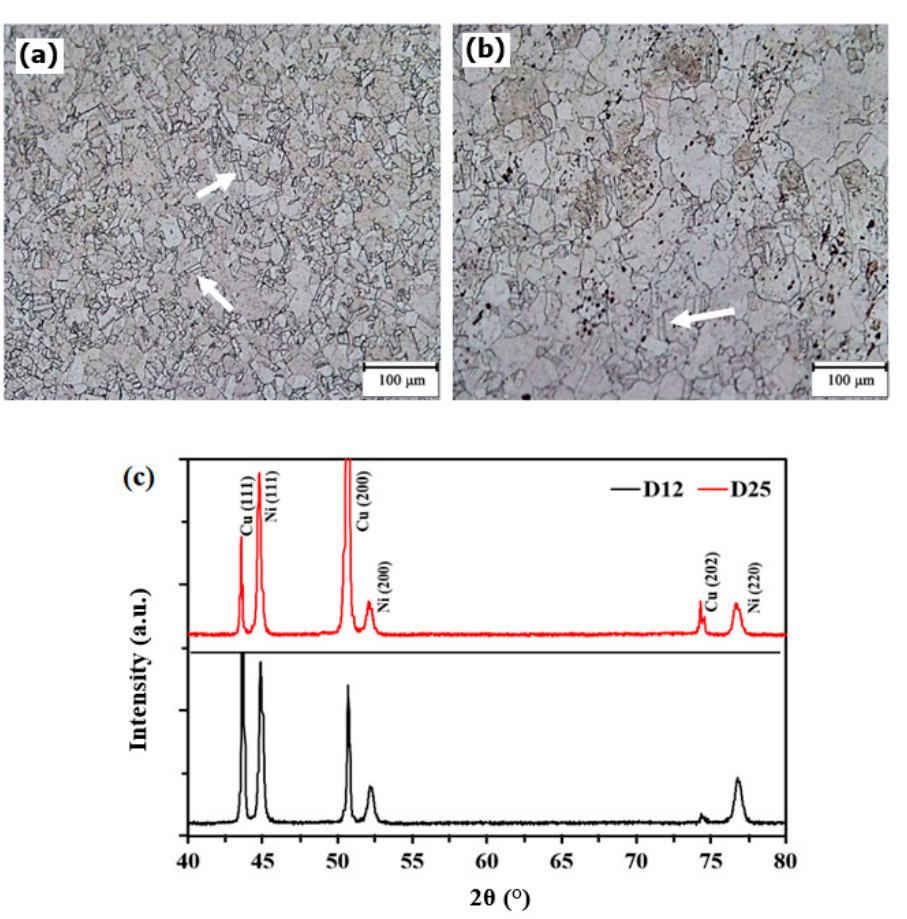
Figure 1. Microstructures of copper substrate with di ff erent grain sizes: ( a ) D12 (12 µ m average grain size) and ( b ) D25 (25 µ m average grain size). Some twins marked with white arrows in SEM images. ( c ) X-ray di ff raction patterns of nickel electrodeposited film on D12 and D25 copper substrates.